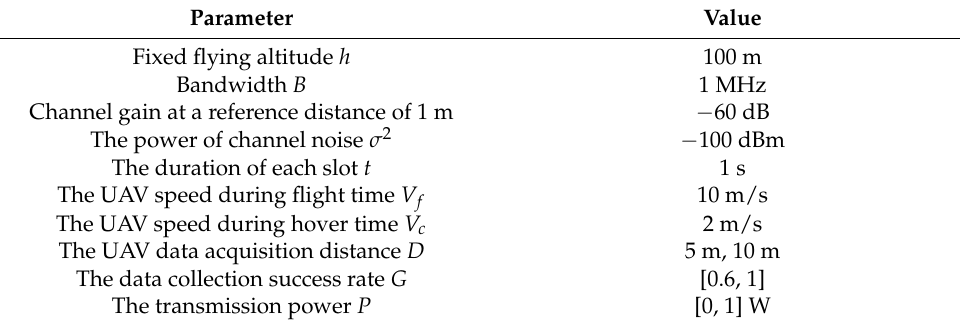
Table 1. The simulated parameters.